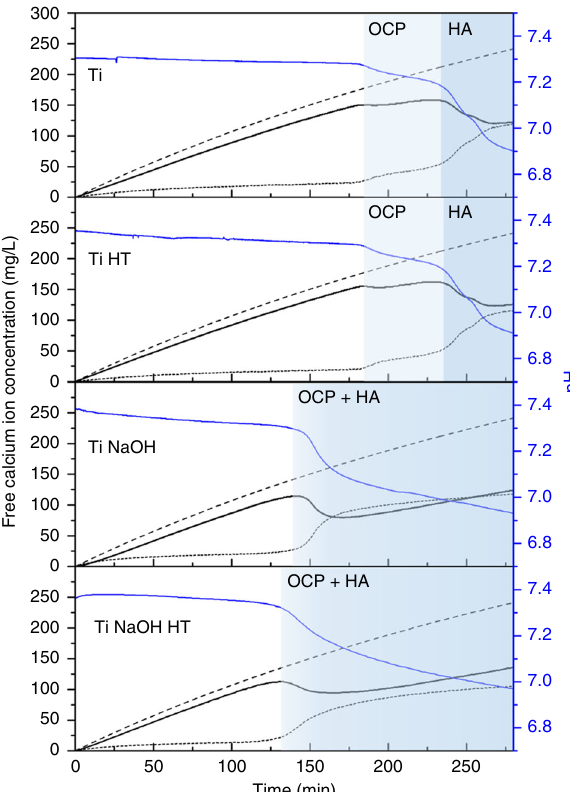
Fig. 3 Free calcium pro fi les of titration experiments using four titanium surfaces. The black lines indicate free calcium concentrations measured by a calcium ISE. The dash lines give the concentration of added amount of calcium ions. The difference of the two is given by the dotted line. The colored region marks the possible dominant crystalline phases identi fi ed from TEM